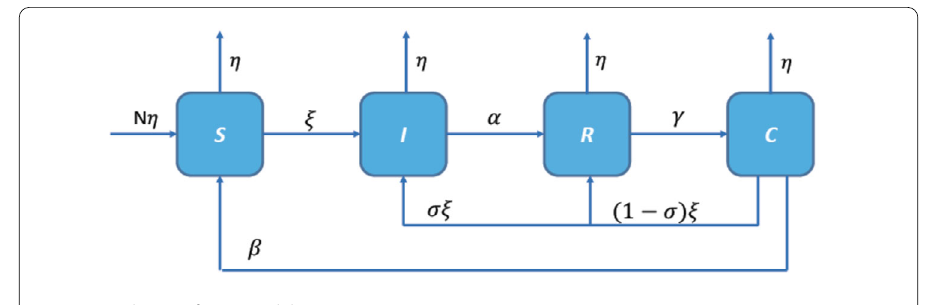
Figure 1 Scheme of SIRC model (1)